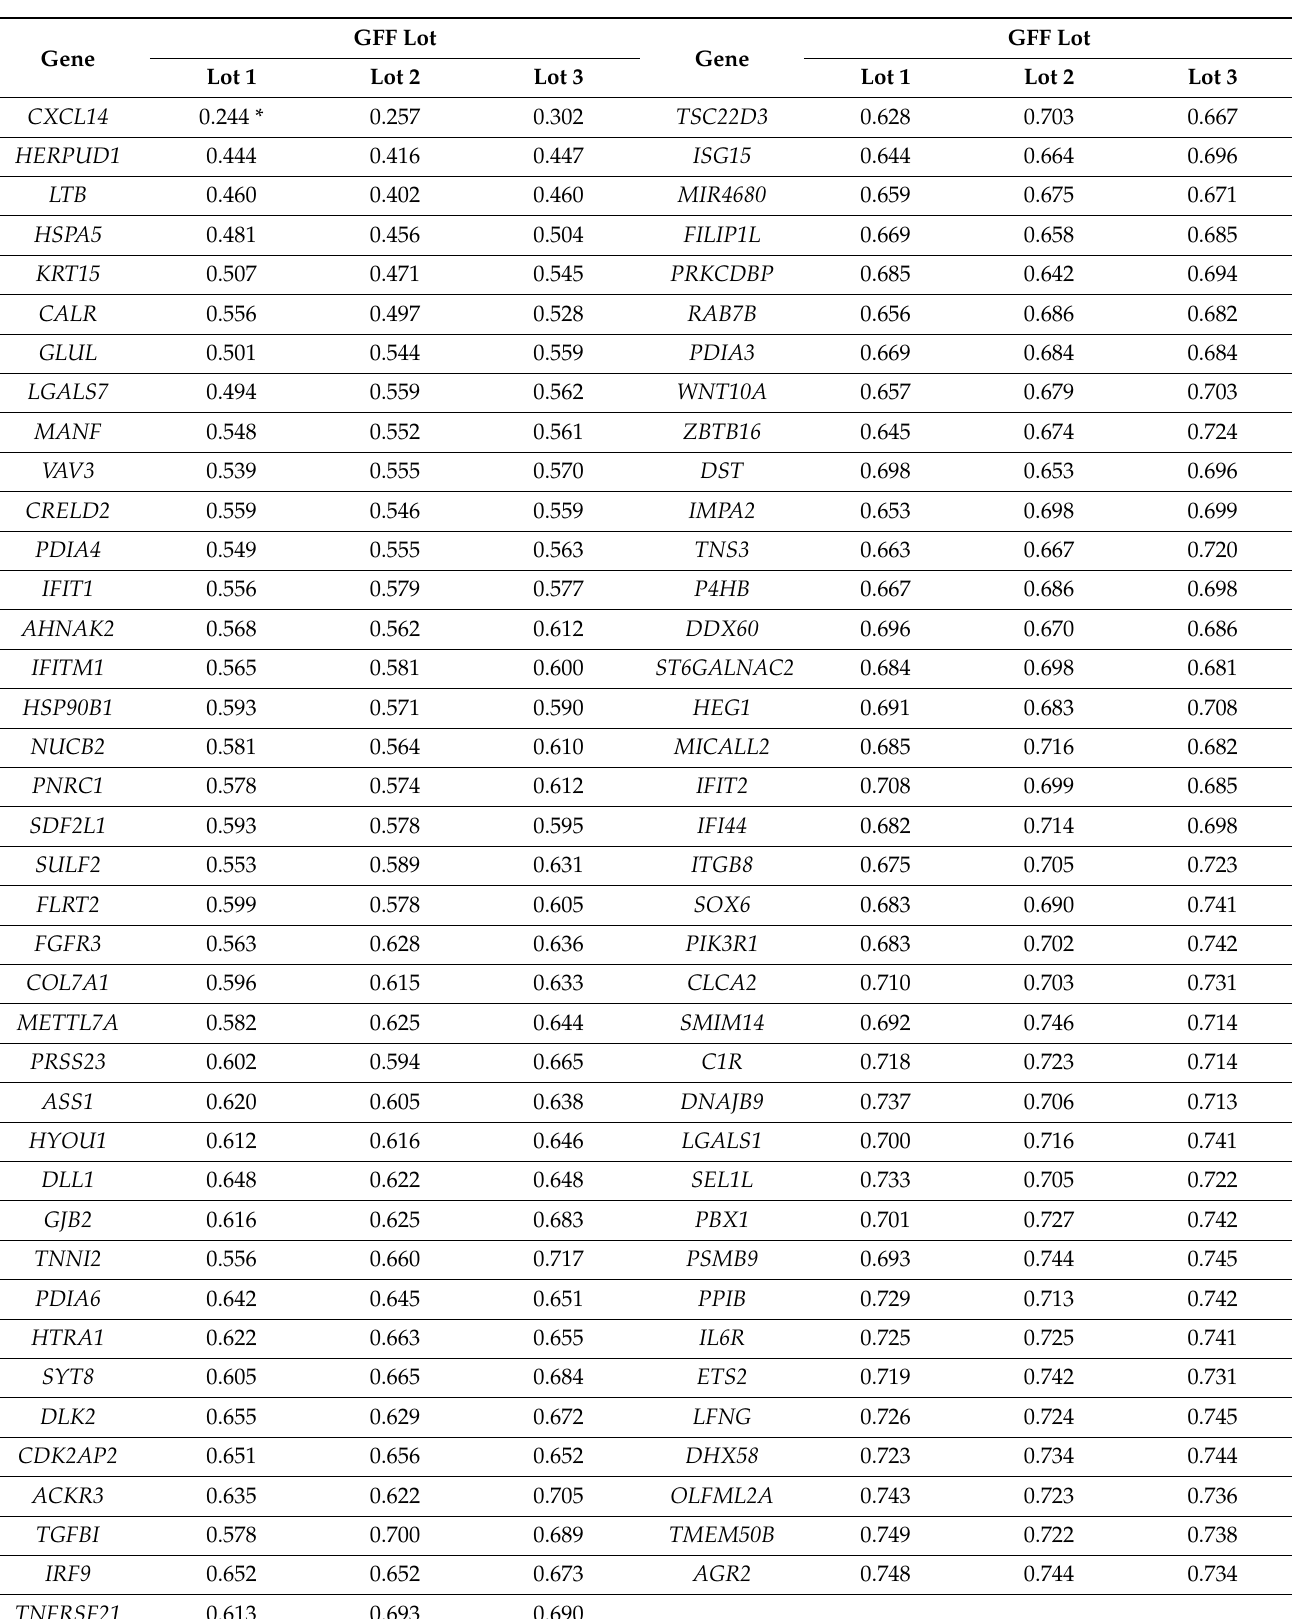
Table 2. Genes downregulated # by different lots of